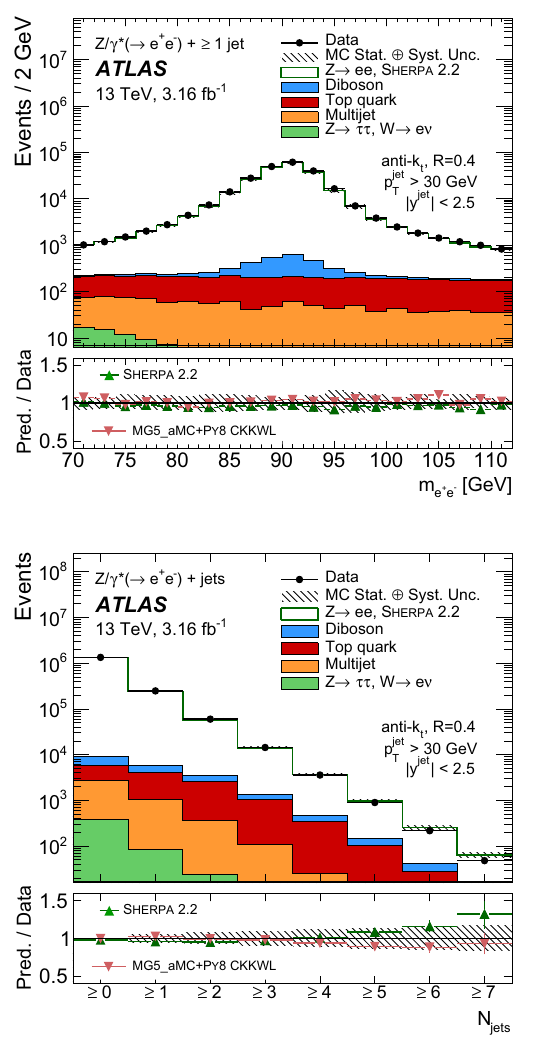
for the signal and background distributions are combined in the hatched band , and the statistical uncertainty is shown on the data points . The uncertainty in the luminosity and the theory uncertainty in the signal prediction are not included in the uncertainty band